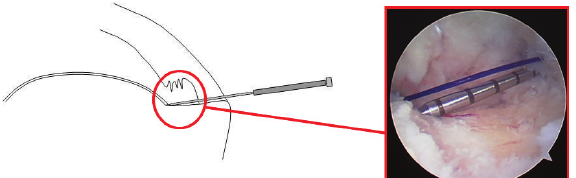
Figure 2: Schematic diagram and corresponding arthroscopic photo (of a right shoulder from a posterior glenohumeral portal) demonstrating the inner metallic sleeve penetrating the intact portion of the rotator cuff laterally at the area of greatest tendon involvement. The “needle tipped” portion of the intra-articular depth guide is inserted tangential to the bone bed and placed adjacent to the articular cartilage. (Note: all arthroscopic photos are oriented in the beach chair position).